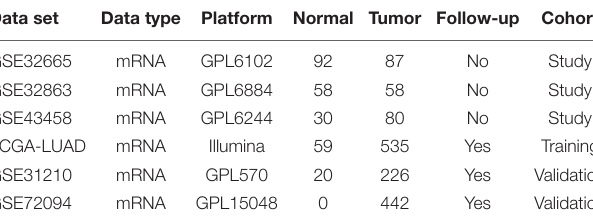
TABLE 1 | The gene expression profiles and data